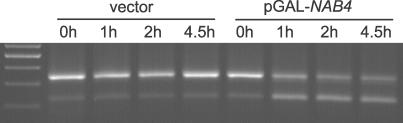
Nab4 Overexpression Affects SUA7 Cleavage Site SelectionShown is the 3′ RACE analysis of the SUA7 transcript during a time course of Nab4 overexpression. Nab4 overexpression was driven by a galactose-inducible promoter. This strain was compared to a vector-only control, induced in parallel. 100-nucleotide molecular weight ladder is shown in the left-most lane with the 600-base pair marker at the top of the gel. Samples were taken before induction and at 1, 2.5, and 4 h post induction.